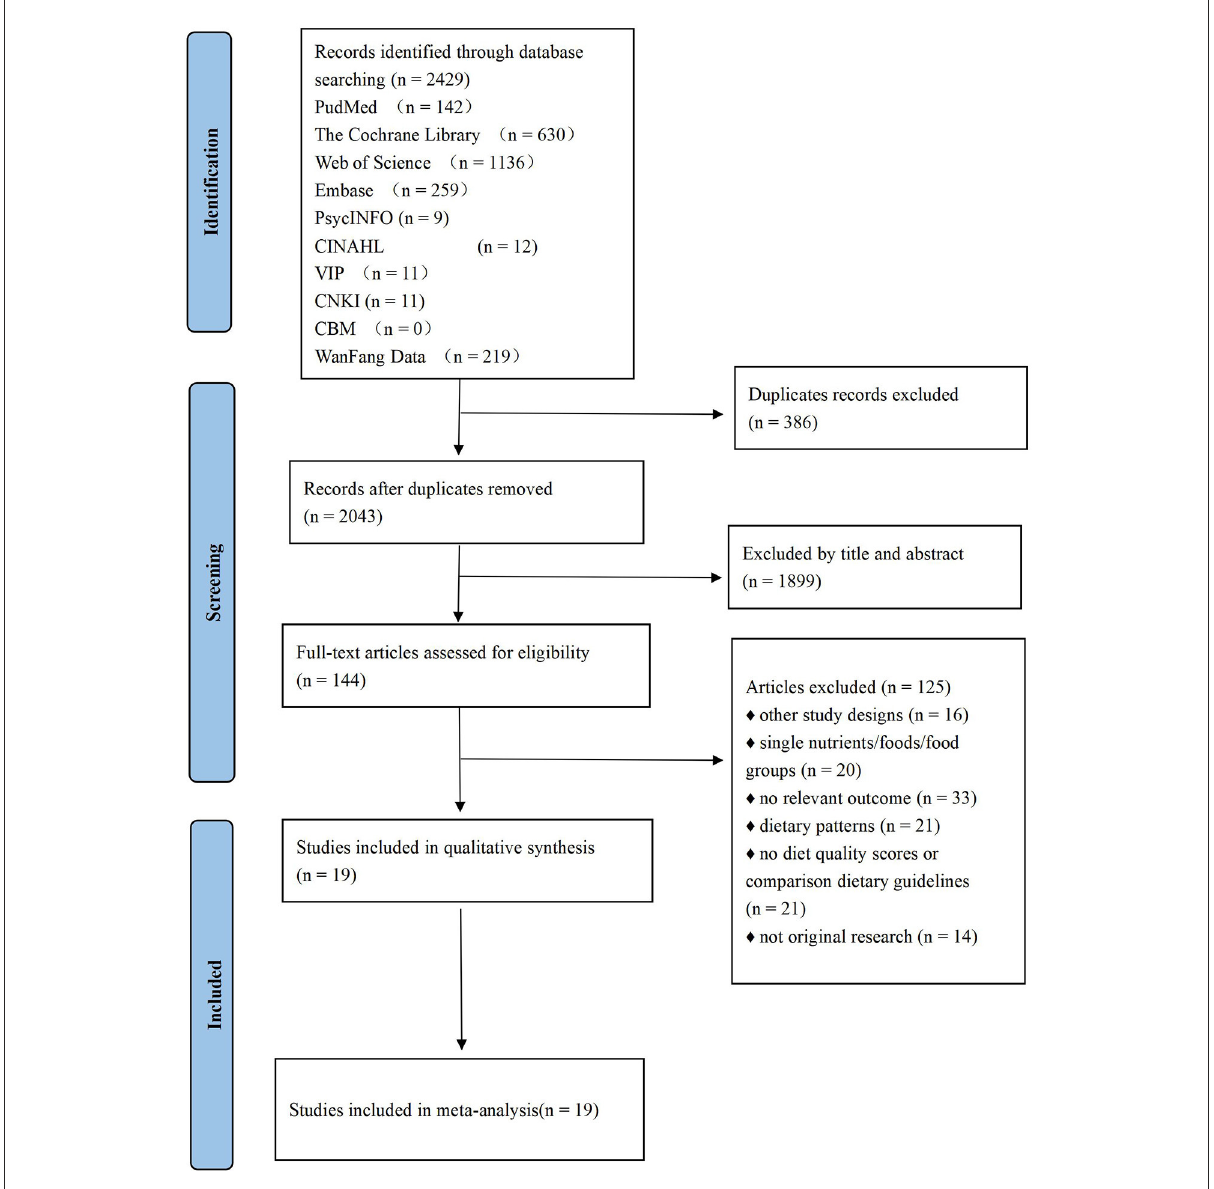
FIGURE1 Flow diagram of included